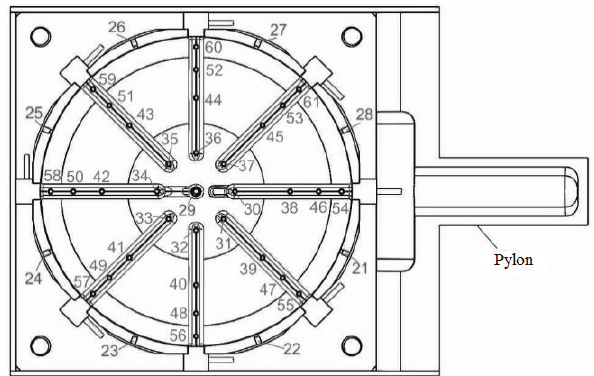
Figure 6. Diagram of static (21 – 29) and total pressure receivers